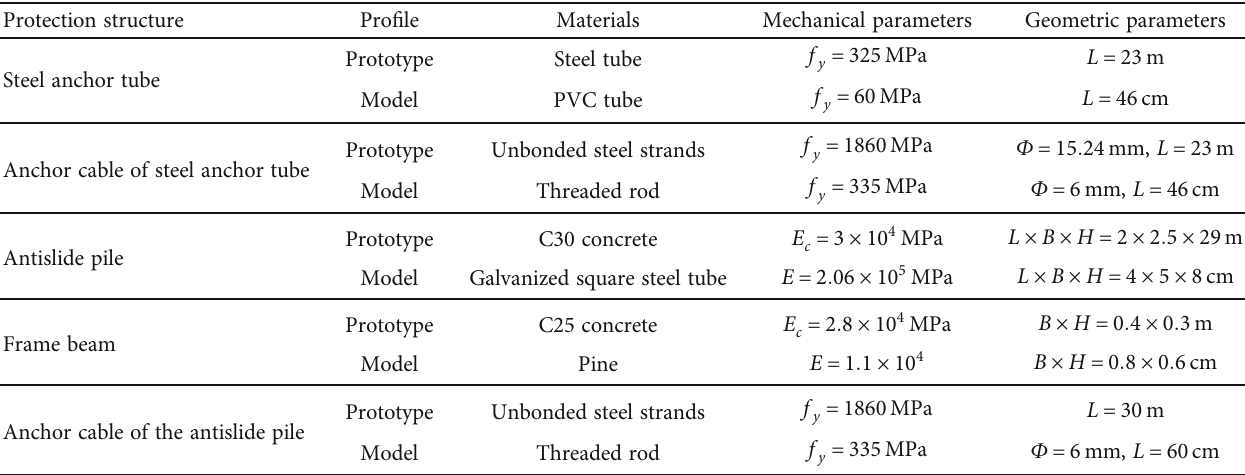
Table 2: Mechanical properties and geometric similarity parameters of protection structures.